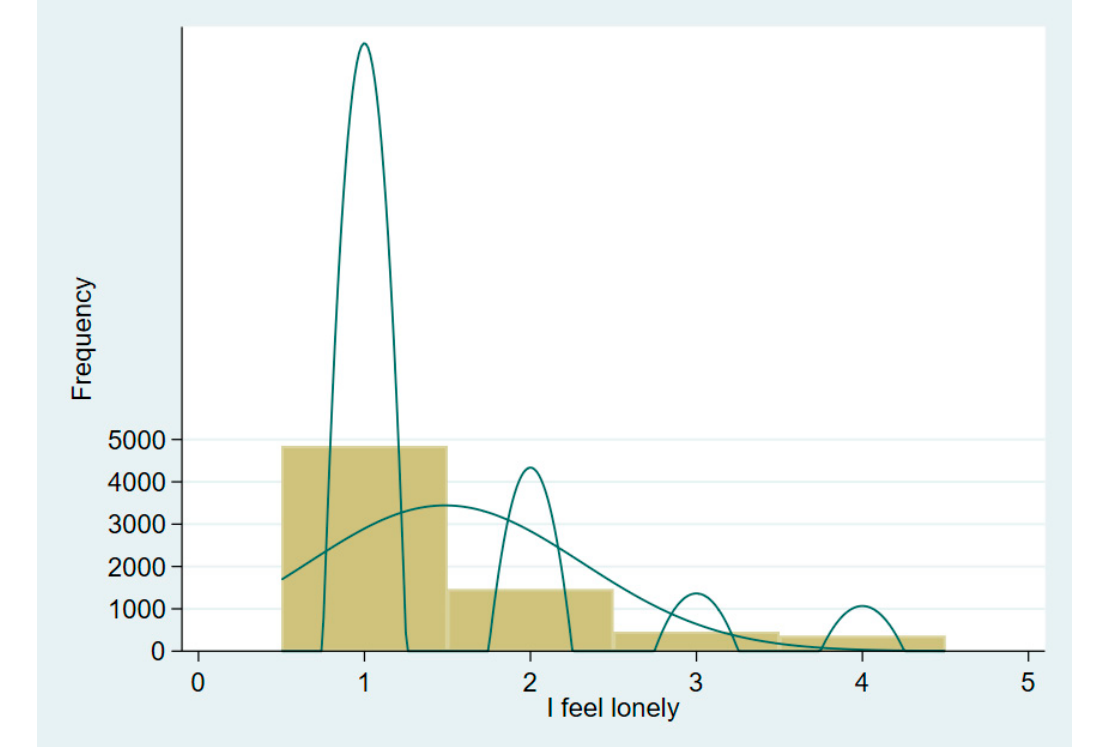
Figure 1. Histogram for loneliness.